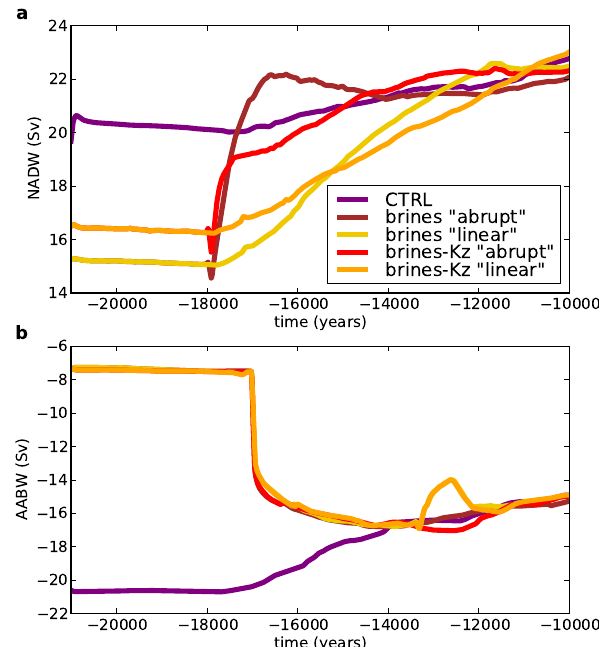
Fig. 12. Evolution of the thermohaline circulation during the deglaciation. (a) Evolution of the maximum value of the North At- lantic stream function (Sv) and (b) evolution of the maximum value of the Southern Ocean stream function